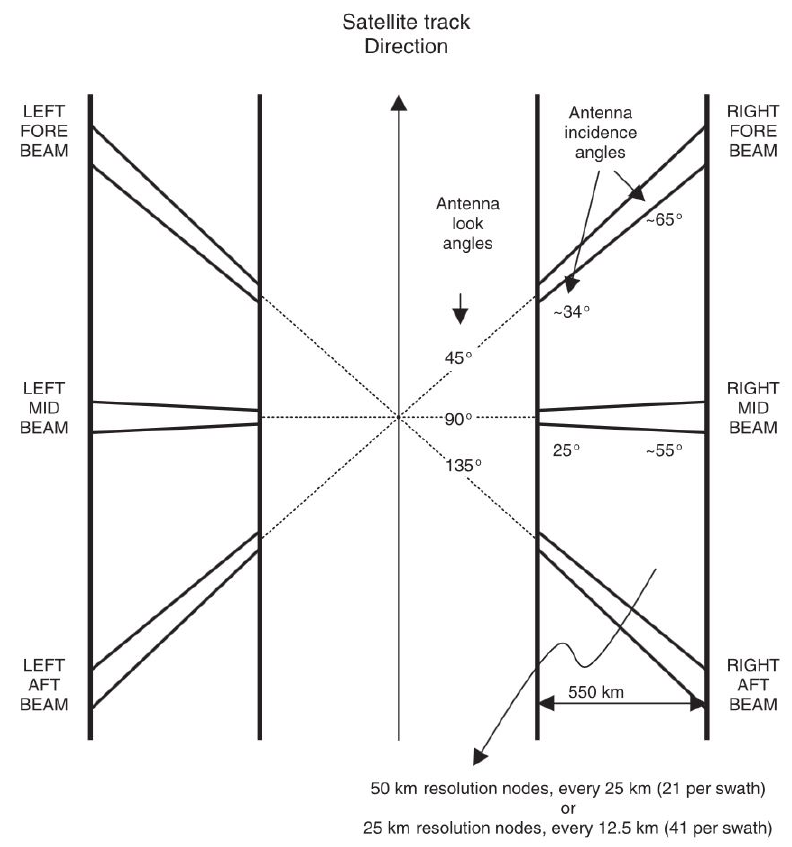
Figure 6. ASCAT measurement geometry